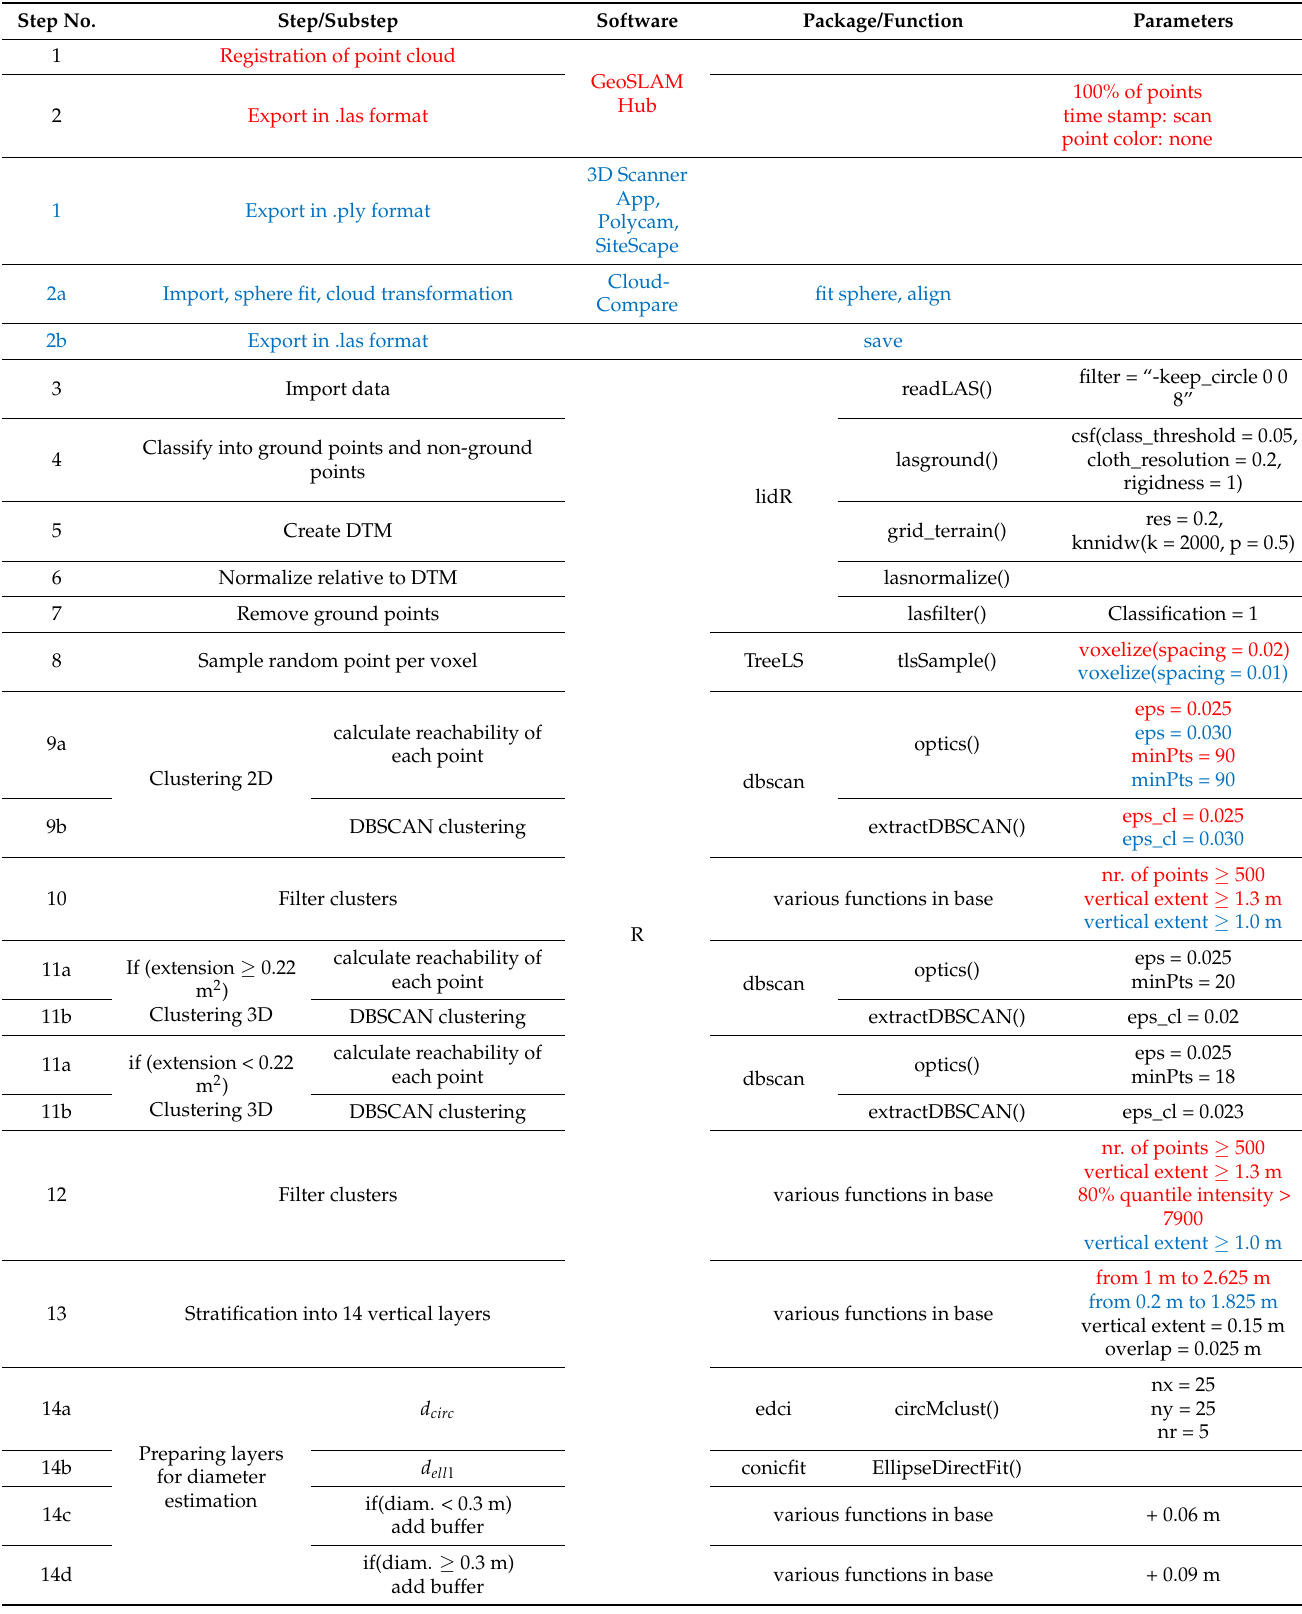
Table A2. Workflow and applied software functions and parameters based on Gollob et al. [50]. Black indicates steps for both iPad and PLS. Blue indicates steps for iPad solely and red indicates steps for PLS